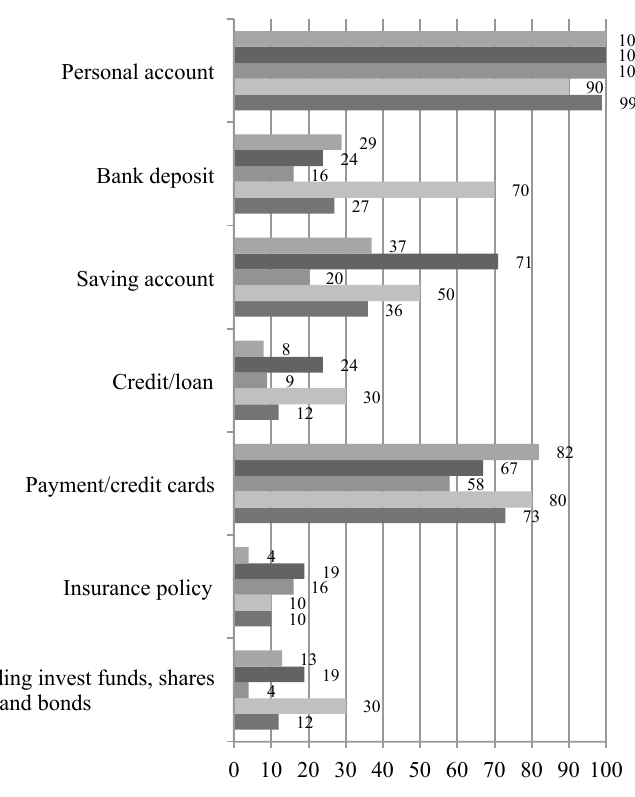
Fig. 3. Financial products and services used by youth (% of responders) During the research, responders were asked what factors they took into account for choosing particular financial products. They could choose the factors from the list and add additional factors in the list, should it have been necessary. Survey results confirm the general importance of charges, fees and interest rates in the process of decision-making. Additionally, respondents pointed safety, friends and family’s opinion, service quality and complexity and friendly procedure as the most important financial decision factors (see table